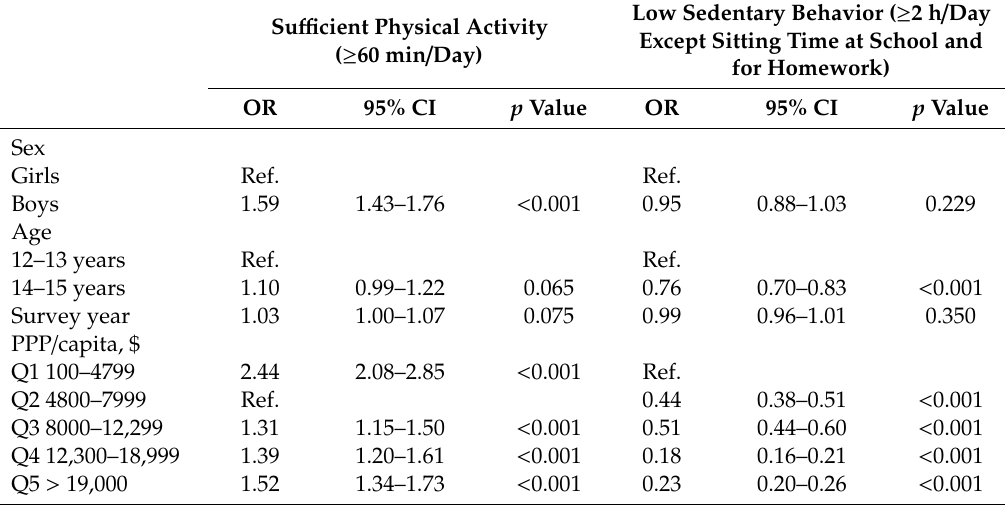
Table 4. Predictors of su ffi cient physical activity and low sedentary behavior in adolescents aged 12–15